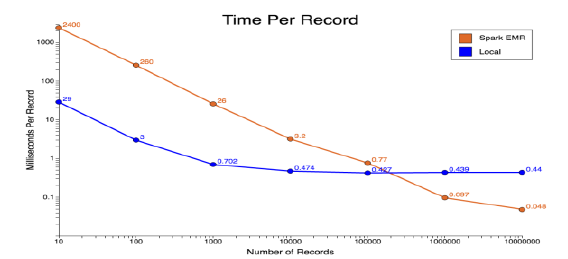
Figure 6. Processing results in AWS